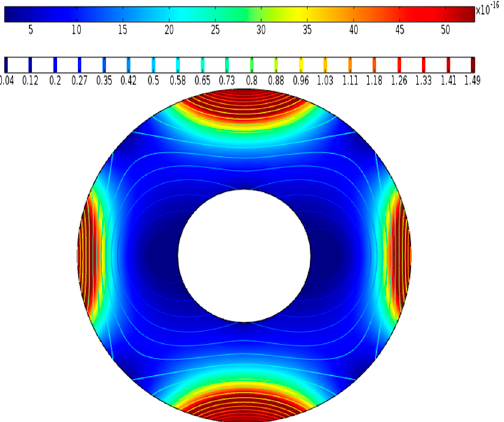
Figure 3. The magnetophoretic ( MAP ) force and magnetization distributions in the reference model.